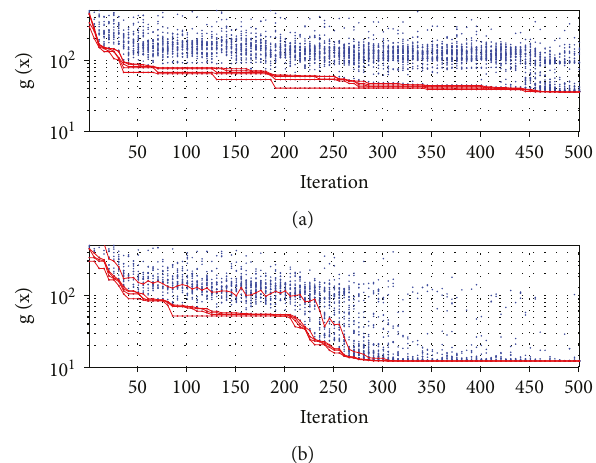
Figure 6: Choice of leading particles. (a) The top 5 rank performers are adopted out of 100 particles as leading particles. (b) The four best fi tters and one 40th rank fi tter are used. The blue and red dots indicate the cost values of ordinary and leading particles,